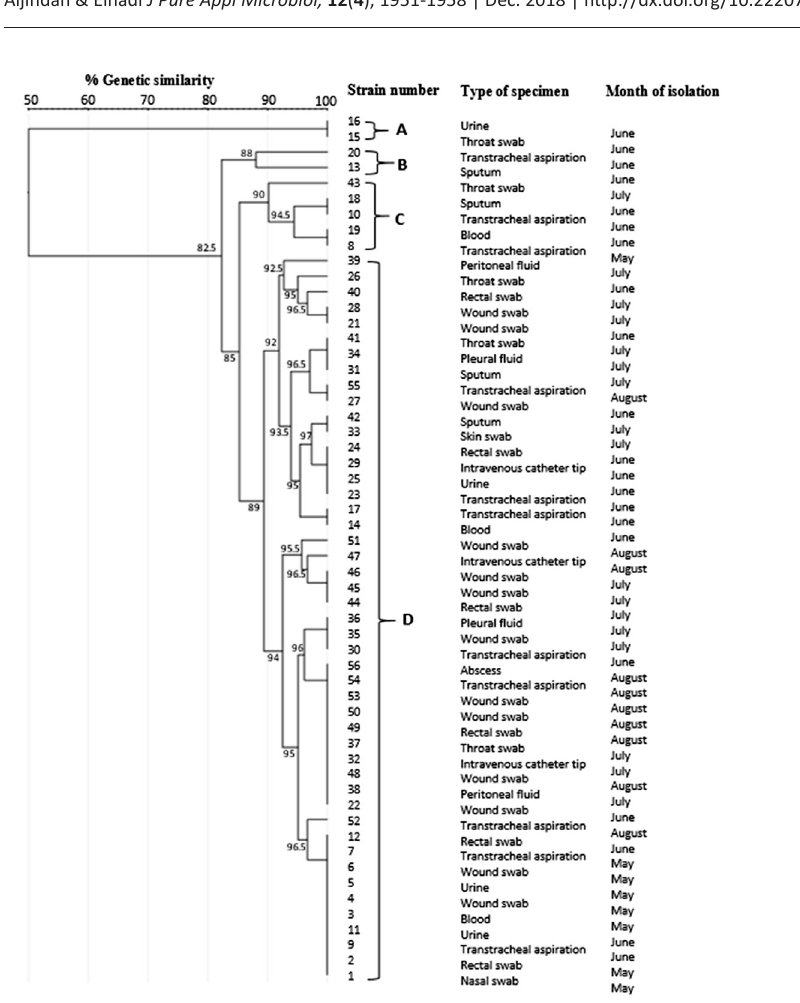
Fig. 3. Dendrogram based on clusters analysis of ERIC-PCR fingerprint data illustrating the relationships among the carbapenem-resistant Acinetobacter baumannii strains. The genetic similarities between the fingerprints were calculated using the Dice coefficient (optimization, 1%; position tolerance, 1%), and the fingerprints were grouped according to their similarities using the unweighted pair-group method using arithmetic averages